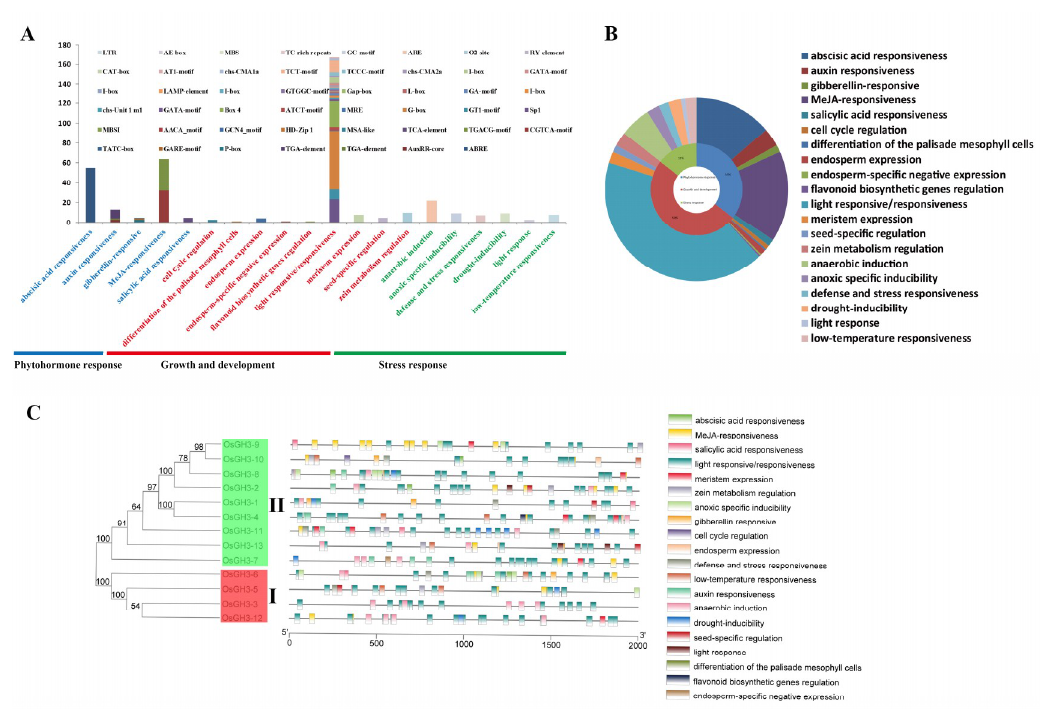
Figure 5. Identification of cis-acting elements in all GH3 genes of Oryza sativa ssp. japonica . ( A ) The different bars represent different primary categories, the different characters represent different secondary categories, and the different colors in histograms represent the number of different promoter elements in each secondary category. ( B ) Pie charts of different sizes indicate the ratio of each primary/secondary category. ( C ) The different groups of GH3 genes in the phylogenetic tree are shown by different colors. The differently colored boxes represent the different secondary